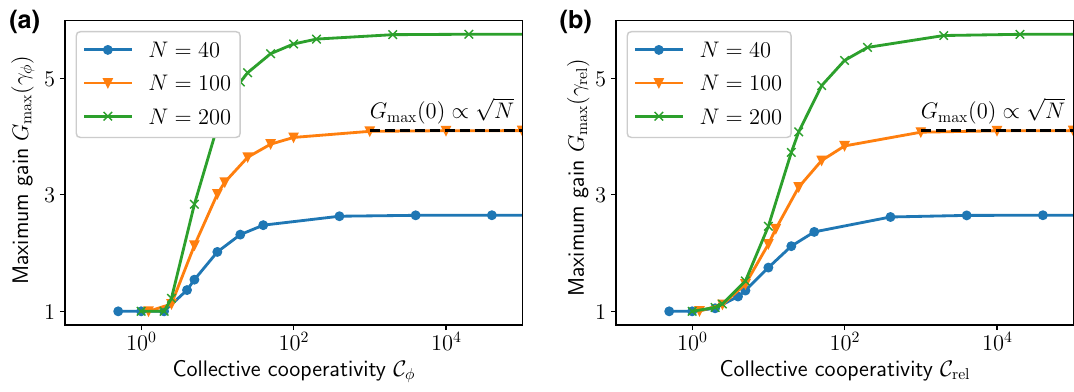
FIG. 5. (a) The maximum gain in the presence of local dephasing, G max (γ φ ) , as a function of the collective cooperativity C φ = N (cid:5)/γ φ [calculated by numerically exact integration of the master equation (21) with γ rel = 0]. Each data point is obtained by maxi- mizing the time-dependent gain G ( t ) over the evolution time t . Collective amplification and local dephasing compete and amplification is observed if C φ (cid:2) 2, i.e., if the collective amplification rate dominates over local decay. (b) Analogous numerical results for maxi- mum gain in the presence of local relaxation, G max (γ rel ) , as a function of the collective cooperativity C rel = N (cid:5)/γ rel (with γ φ = 0). We again see that the collective cooperativity is the relevant parameter for obtaining maximum